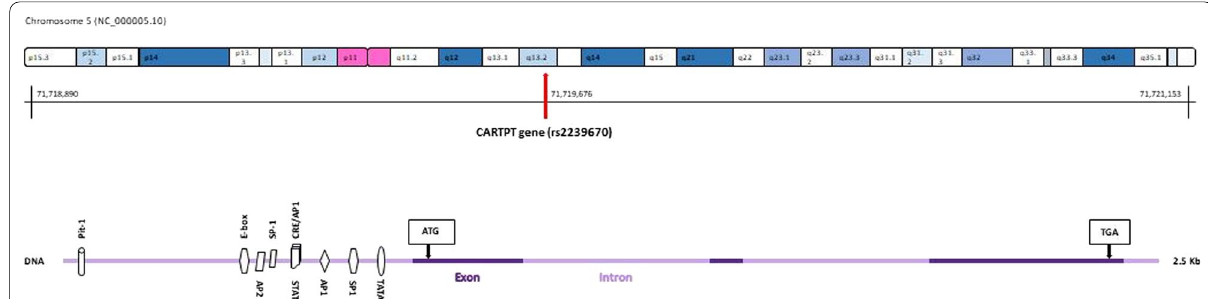
Fig. 1 Overview of genomic structure of the CARTPT gene and location of rs2239670